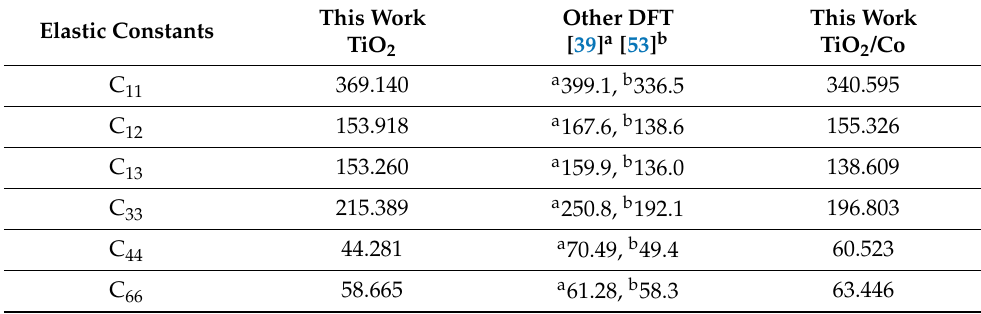
Table 3. Elastic constants (C ij ; GPa) for pure and Co-doped TiO 2 anatase comparison data.